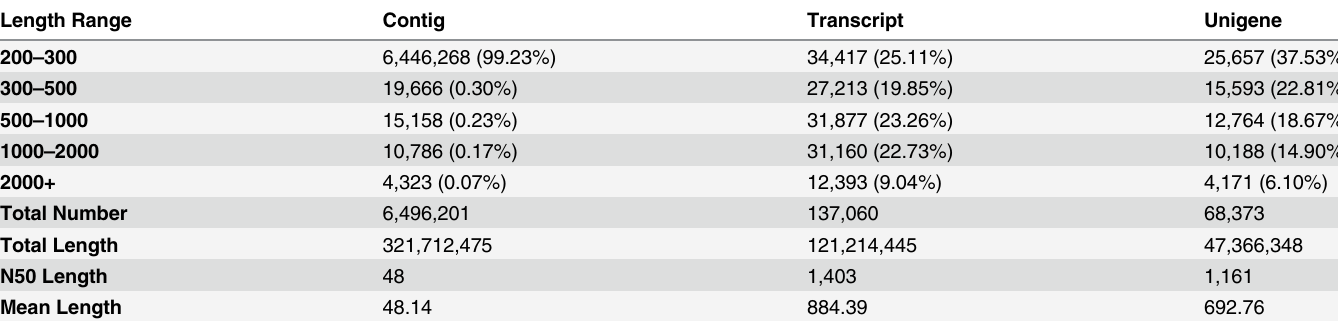
Table 2. Overview of de novo sequencing and assembly.